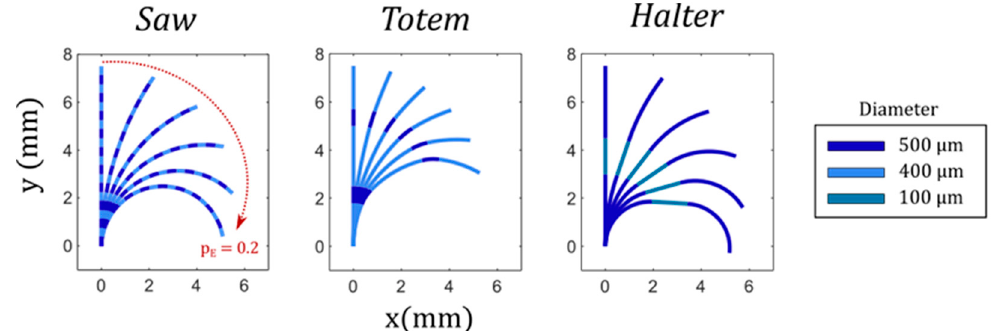
Figure 9. Analytical model results. Six configurations are depicted for each actuator at the same normalised pressure inputs ( p E ) varying from 0 (undeformed) to 0.2 (maximum deformation). Segments are distinguished with the same colour code as used in Figure 1.